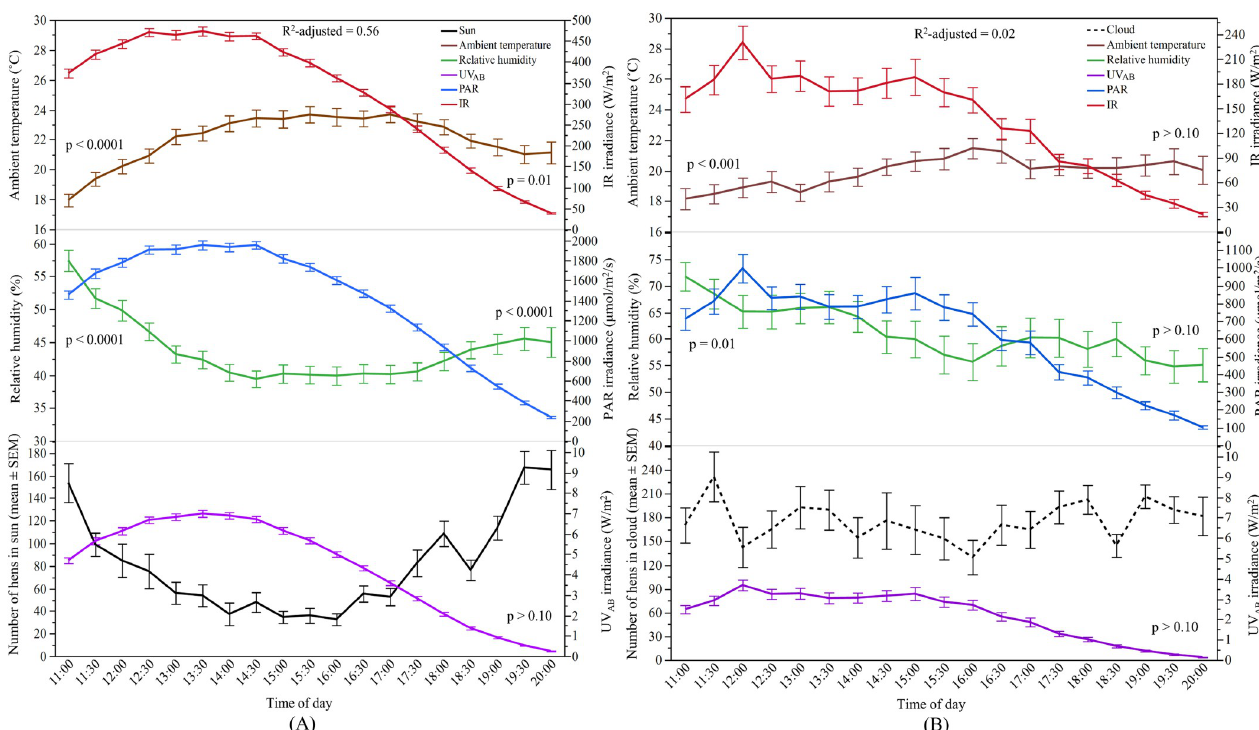
Fig 4. Relationship between sunlight spectrums and weather variables with the number of hens in the ‘sun’ and ‘cloud’ in TAS: (A) Y-axis (left): The mean ( ± SEM) number of hens in the ‘sun’, and the mean ( ± SEM) relative humidity and ambient temperature; Y-axis (right): the mean ( ± SEM) irradiance of UV AB (ultraviolet radiation A and B wavelengths), PAR (photosynthetically active radiation), and IR (infrared radiation); (B) Y-axis (left): The mean ( ± SEM) number of hens in the ‘cloud’, and the mean ( ± SEM) relative humidity and ambient temperature; Y-axis (right): the mean ( ± SEM) irradiance of UV AB (ultraviolet radiation A and B wavelengths), PAR (photosynthetically active radiation), and IR (infrared radiation). p > 0.10 indicates the variable had no significant effect and was removed from the final